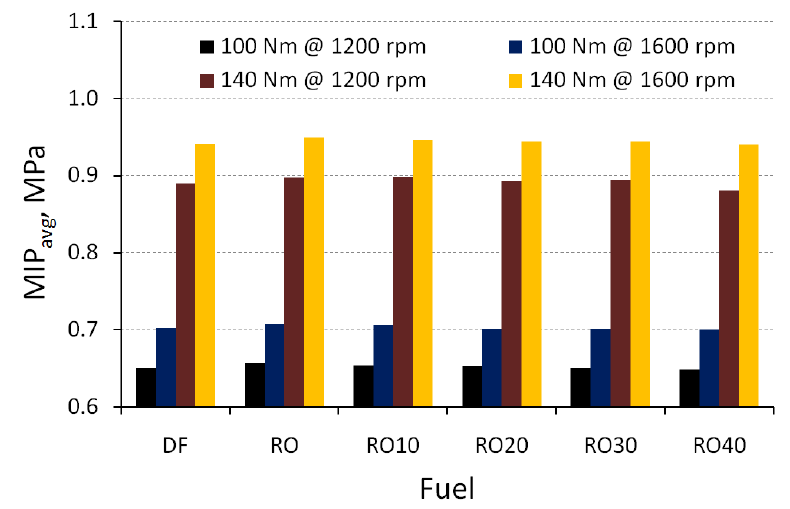
Figure 3. The MIP avg calculated for the AD3.152 engine fueled with tested